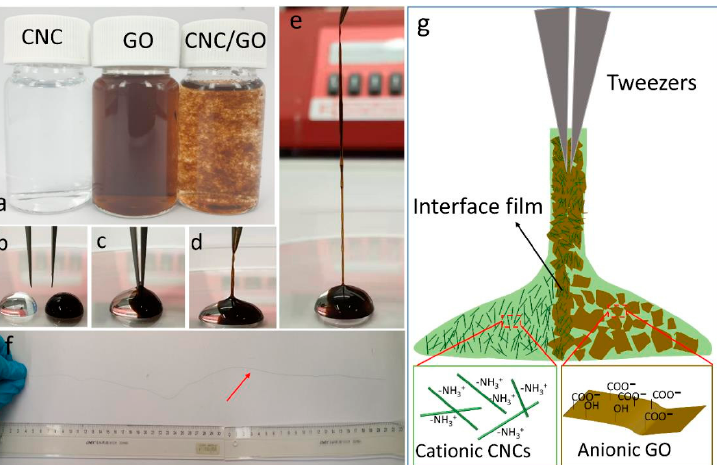
Figure 14. ( a ) suspensions of cationic CNC and GO and a dual precipitated complex after simple mixing; ( b – e ) CNC/GO hybrid filament drawing process; ( f ) a single dried CNC/GO hybrid filament with a diameter of ~33 µm and a length of 53 cm; ( g ) a scheme illustrating the CNC / GO hybrid filament drawing process. Reproduced with permission from Reference [178]. Licensed under a